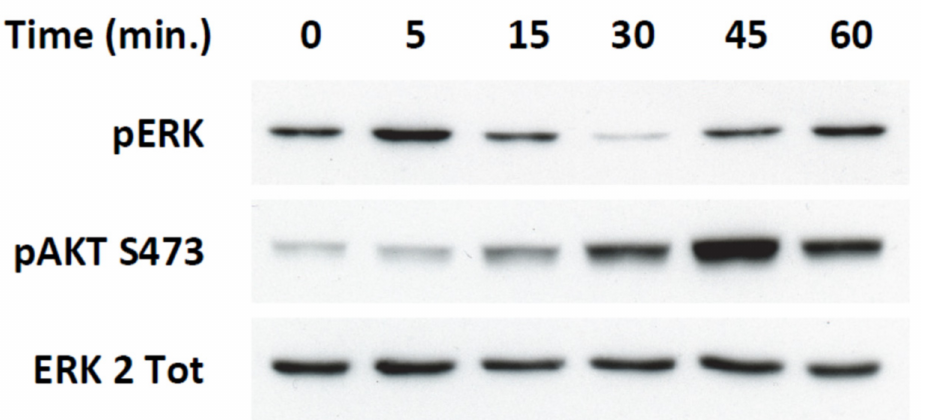
Figure A8. Apelin receptor is expressed in glucagonoma INR1-G9 cell line. INR1-G9 cell line was serum-starved for 20 h. After stimulation with 500 nM apelin for the indicated times, they were lysed and analyzed by SDS-PAGE and immunoblotted. Western blots were probed with anti-phospho-Thr 202/Tyr 204 ERK1 and ERK2, anti-phospho-Ser 473 Akt and anti-ERK2. Representative Western blots from n =